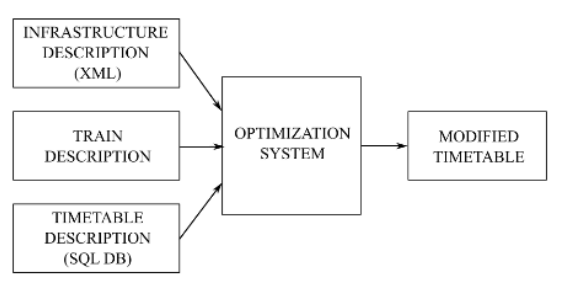
Figure 2. Optimization system and its